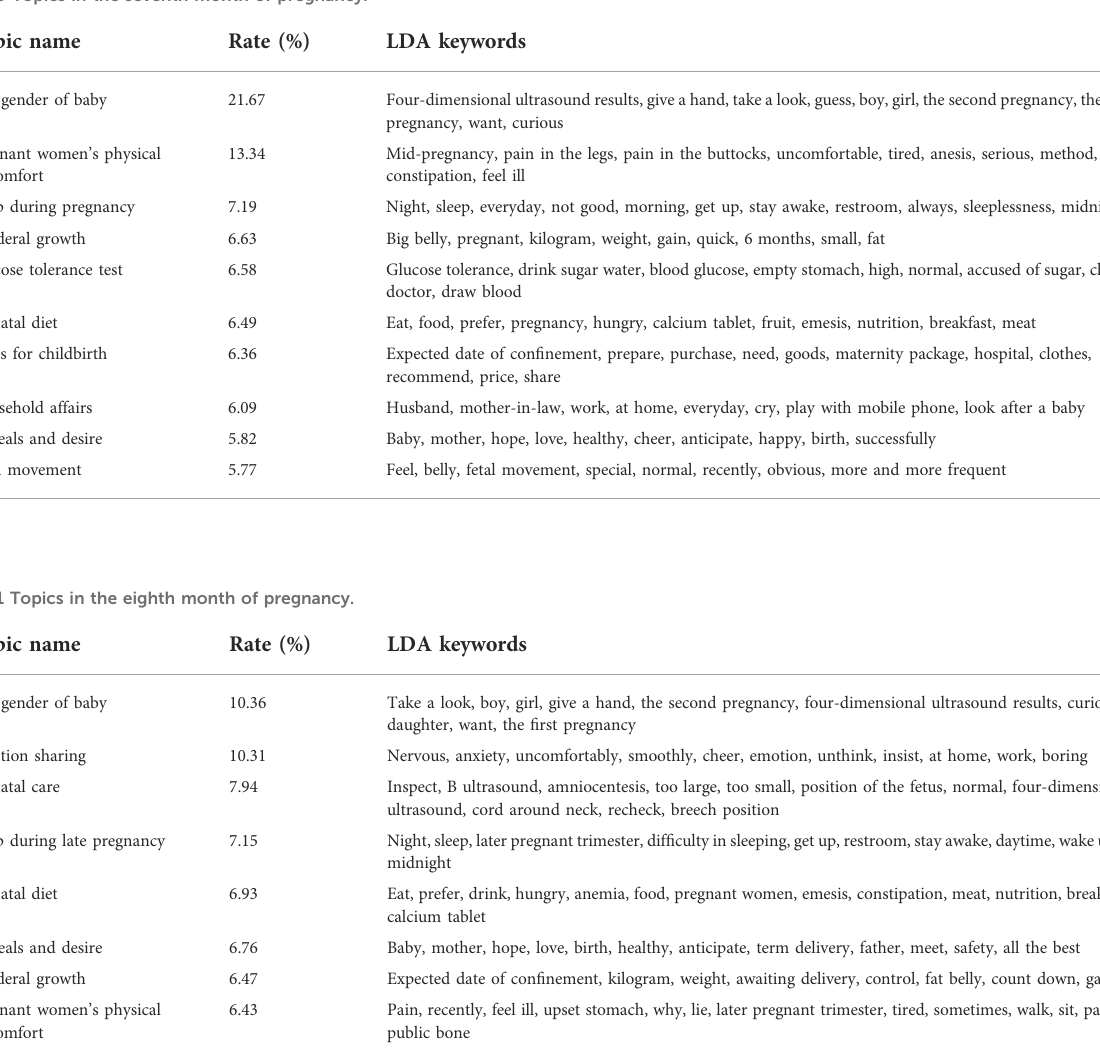
TABLE 10 Topics in the seventh month of pregnancy.